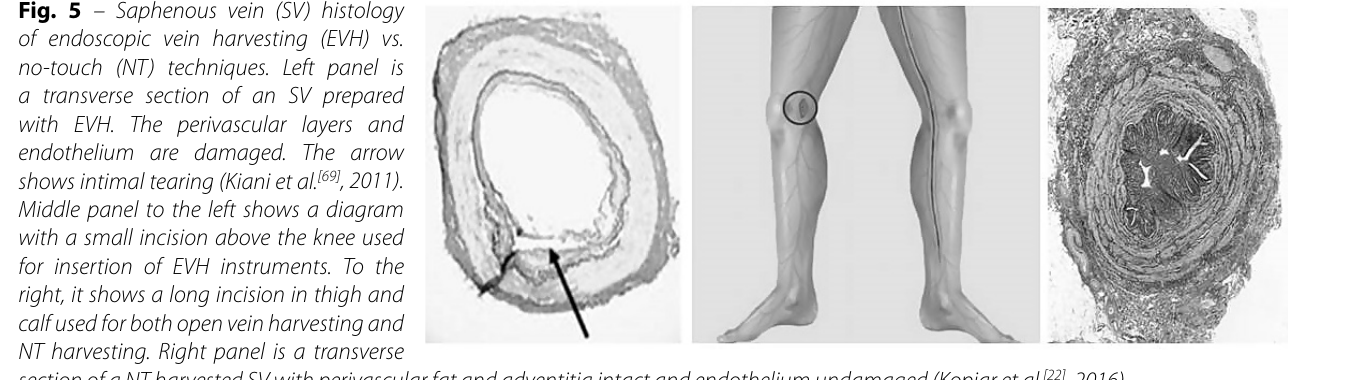
Fig. 5 – Saphenous vein (SV) histology of endoscopic vein harvesting (EVH) vs. no-touch (NT) techniques. Left panel is a transverse section of an SV prepared with EVH. The perivascular layers and endothelium are damaged. The arrow shows intimal tearing (Kiani et al. [69] , 2011). Middle panel to the left shows a diagram with a small incision above the knee used for insertion of EVH instruments. To